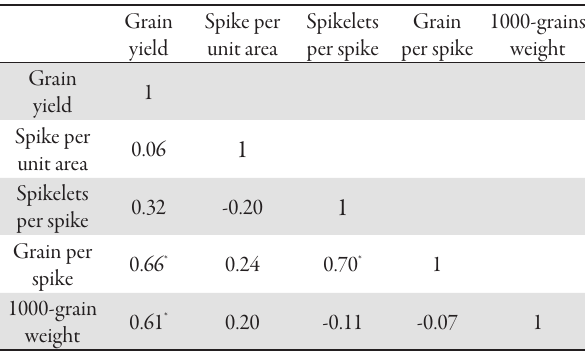
Tab. 4. Correlation coefficient between grain yield and yield components of wheat